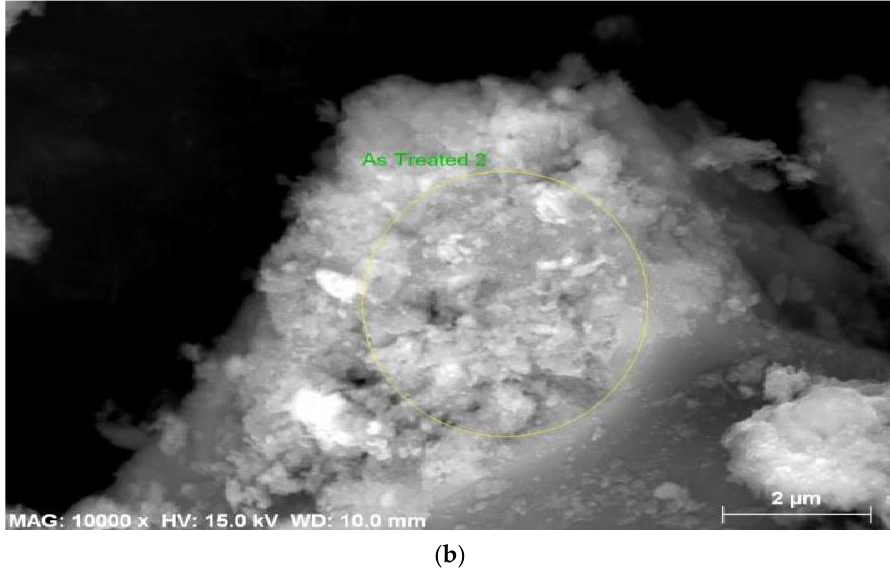
Figure 7. BSEI image of fines of ( a ) original Skye sand and ( b ) Skye sand after treatment.